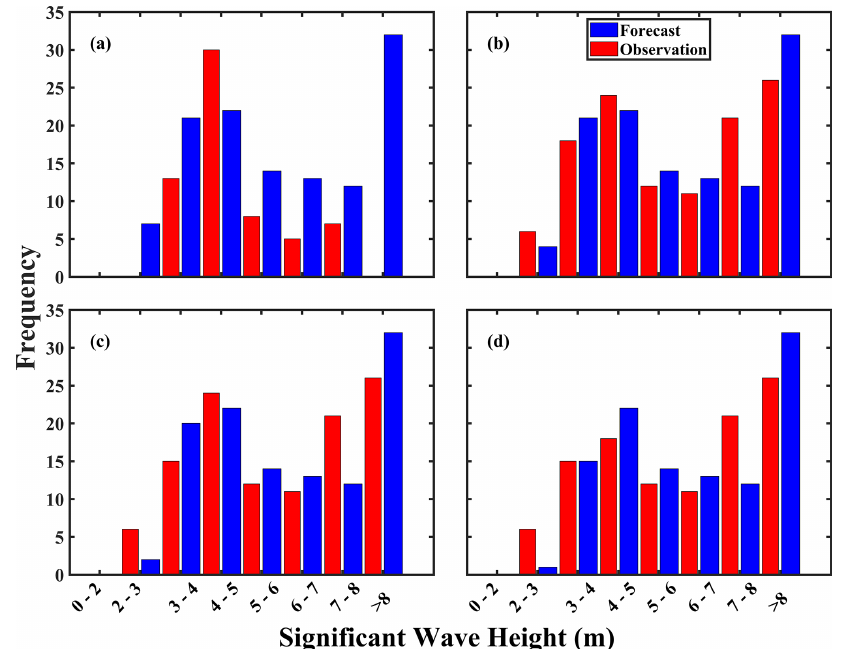
Figure 8. Same as Fig. 7, but for Hurricane Sandy. Results for the 9h forecast are presented in Fig. S3.